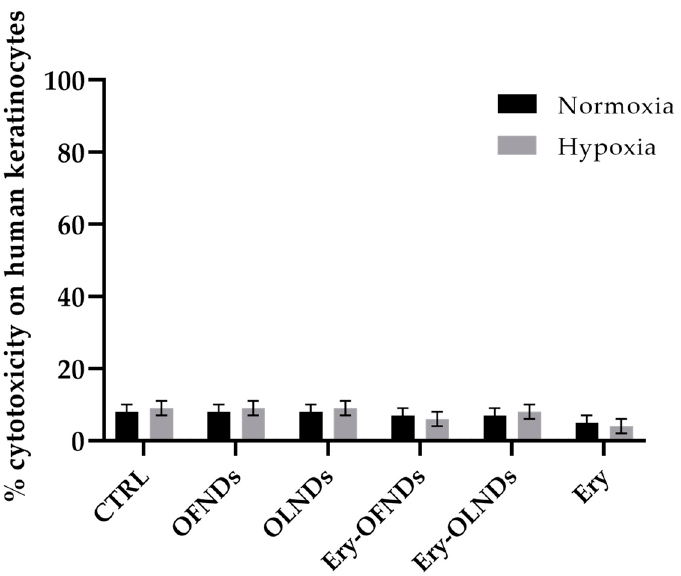
Figure 3. Cytotoxicity of all ND formulations, determined by LDH assay, on human keratinocytes (HaCaT cells), either in normoxia or in hypoxia.